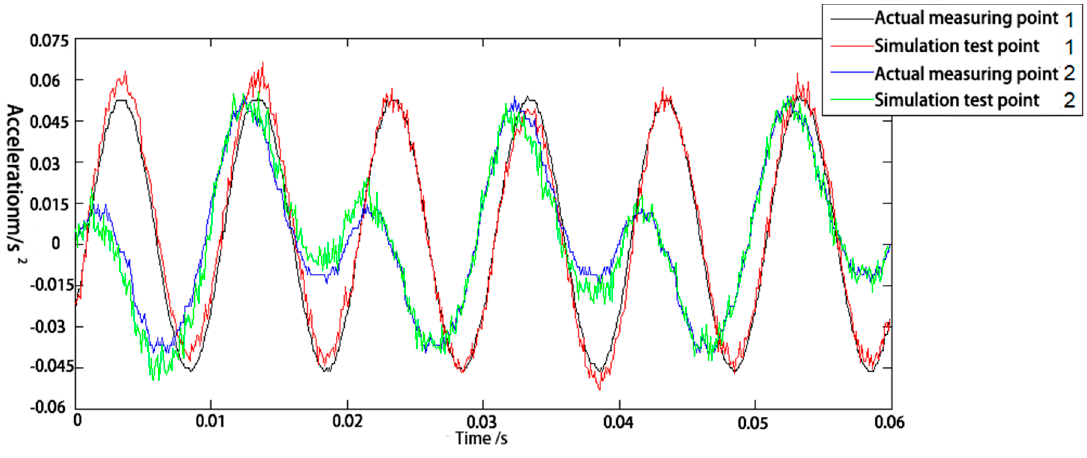
Figure 11. ( a ) Experiment locations of measurement points; ( b ) Simulation locations of measurement points.